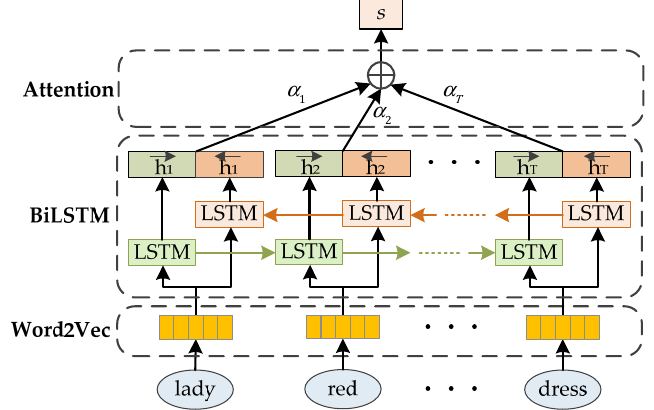
Figure 5. The structure of cubic attention mechanism. ⊗ denotes element-wise product, ⨁ denotes element-wise sum.